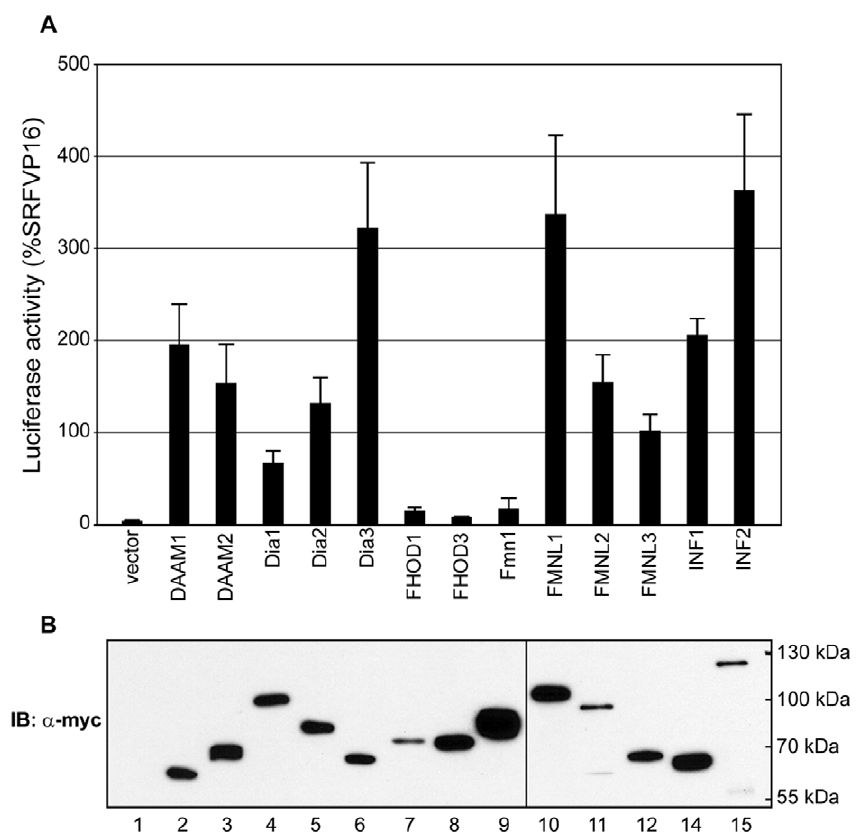
Figure 3. Expression of formin FH1–FH2 derivatives that induce stress fiber formation also induce activation of an SRF reporter gene. A ) NIH 3T3 fibroblasts were transiently transfected with an SRF luciferase reporter gene and the indicated formin FH1FH2 derivative. Formin derivatives that induce stress fiber formation also induce activation of the SRF reporter gene. Expression of FHOD1, FHOD3 and Fmn1 FH1FH2 derivatives fail to induce robust activation of the SRF reporter consistent with their effects on stress fiber formation. Reporter activation is expressed relative to an SRF-VP16 control fusion protein. N=4, error bars = SEM. B ) Equivalent samples of transfected cell lysates from (A) were subjected to SDS-PAGE and immunoblotted to detect the myc epitope tag on the expressed formin proteins; lane order matches the order in